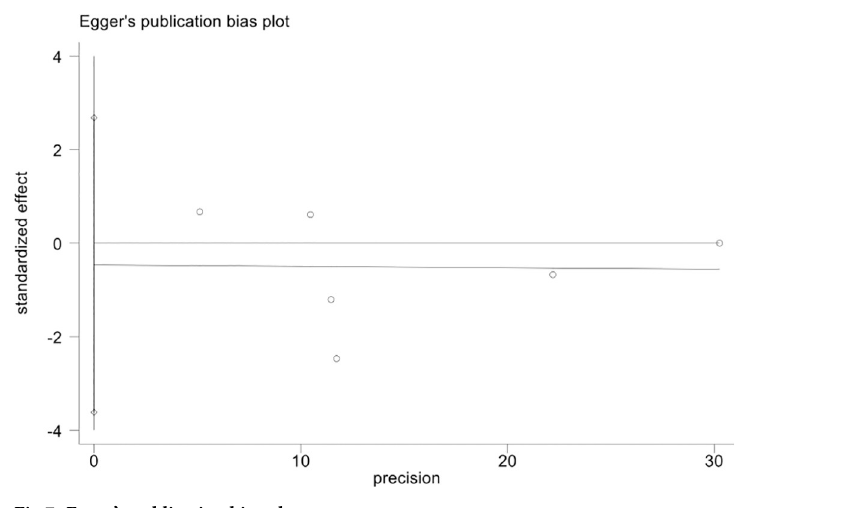
Fig 7. Egger’s publication bias plot.